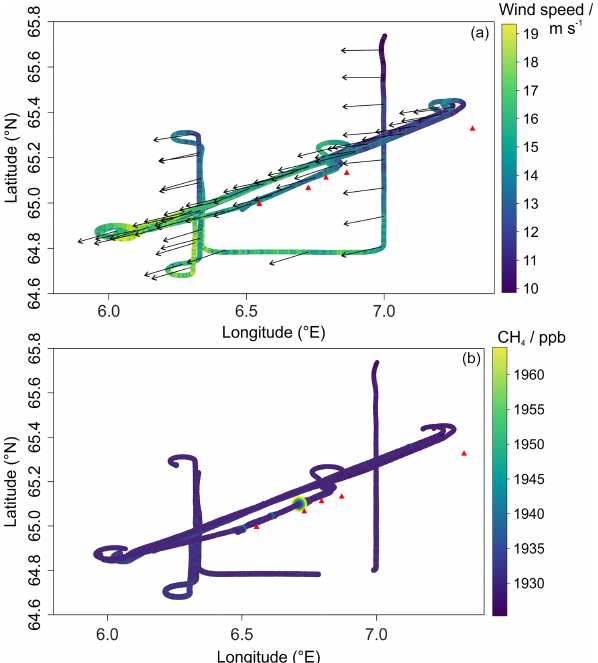
Figure B1. Flight track for flight C193, (a) colour-coded by the wind speed, with arrows denoting the wind direction over the course of the flight, and (b) colour-coded by the CH 4 mixing ratios. The red triangles represent the locations of nearby offshore O&G facilities.